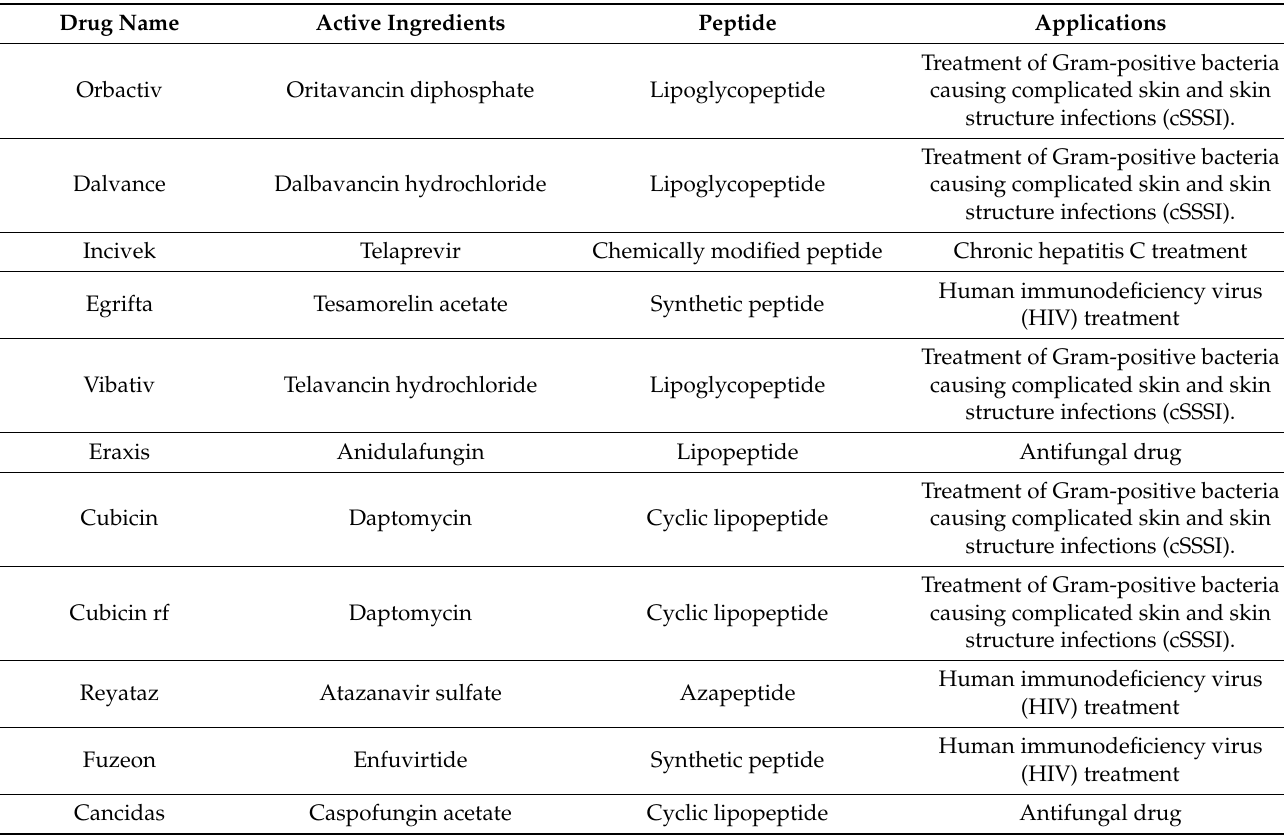
Table 1. Antibacterial, antiviral, and antifungal peptides approved by the FDA since 1999 until 2019